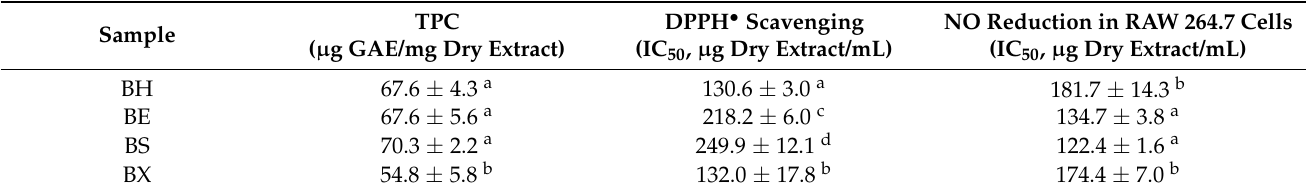
Table 5. Total phenolic content (TPC) and IC 50 values obtained for the antioxidant (DPPH • scaveng- ing) and anti-inflammatory potential (NO reduction in RAW 264.7 cells) of the methanol extracts of B. monnieri obtained from different environments in Mexico